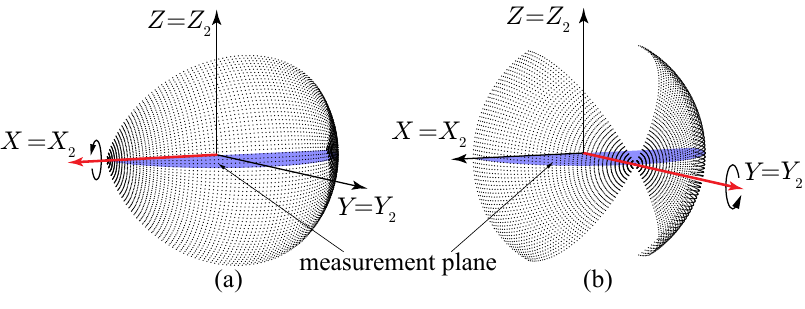
Figure 1. 3D scanning configurations: ( a ) pitching; ( b )